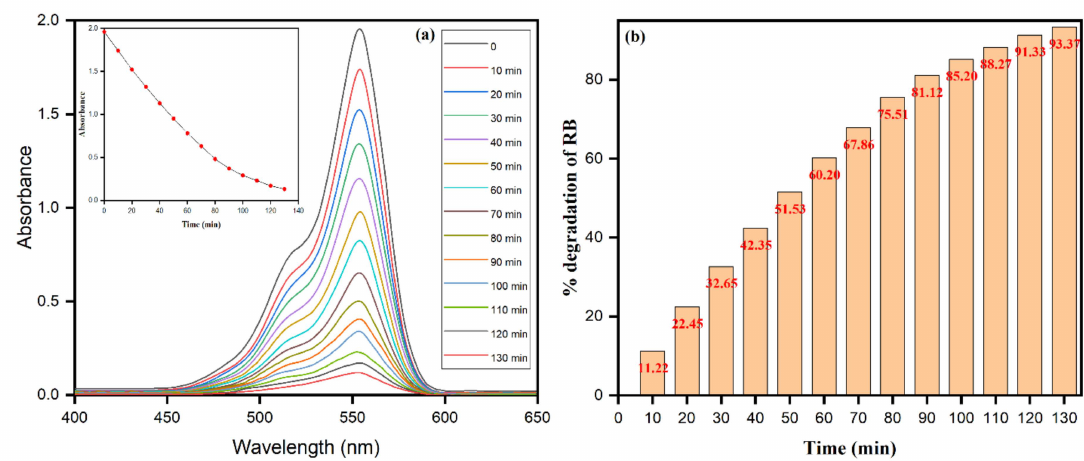
Figure 12. ( a ) Photocatalytic degradation of RB dye at di ff erent time intervals in the presence of AgNPs. ( b ) E ff ect of irradiation time on the photocatalytic degradation of RB by AgNPs e ffi ciency.